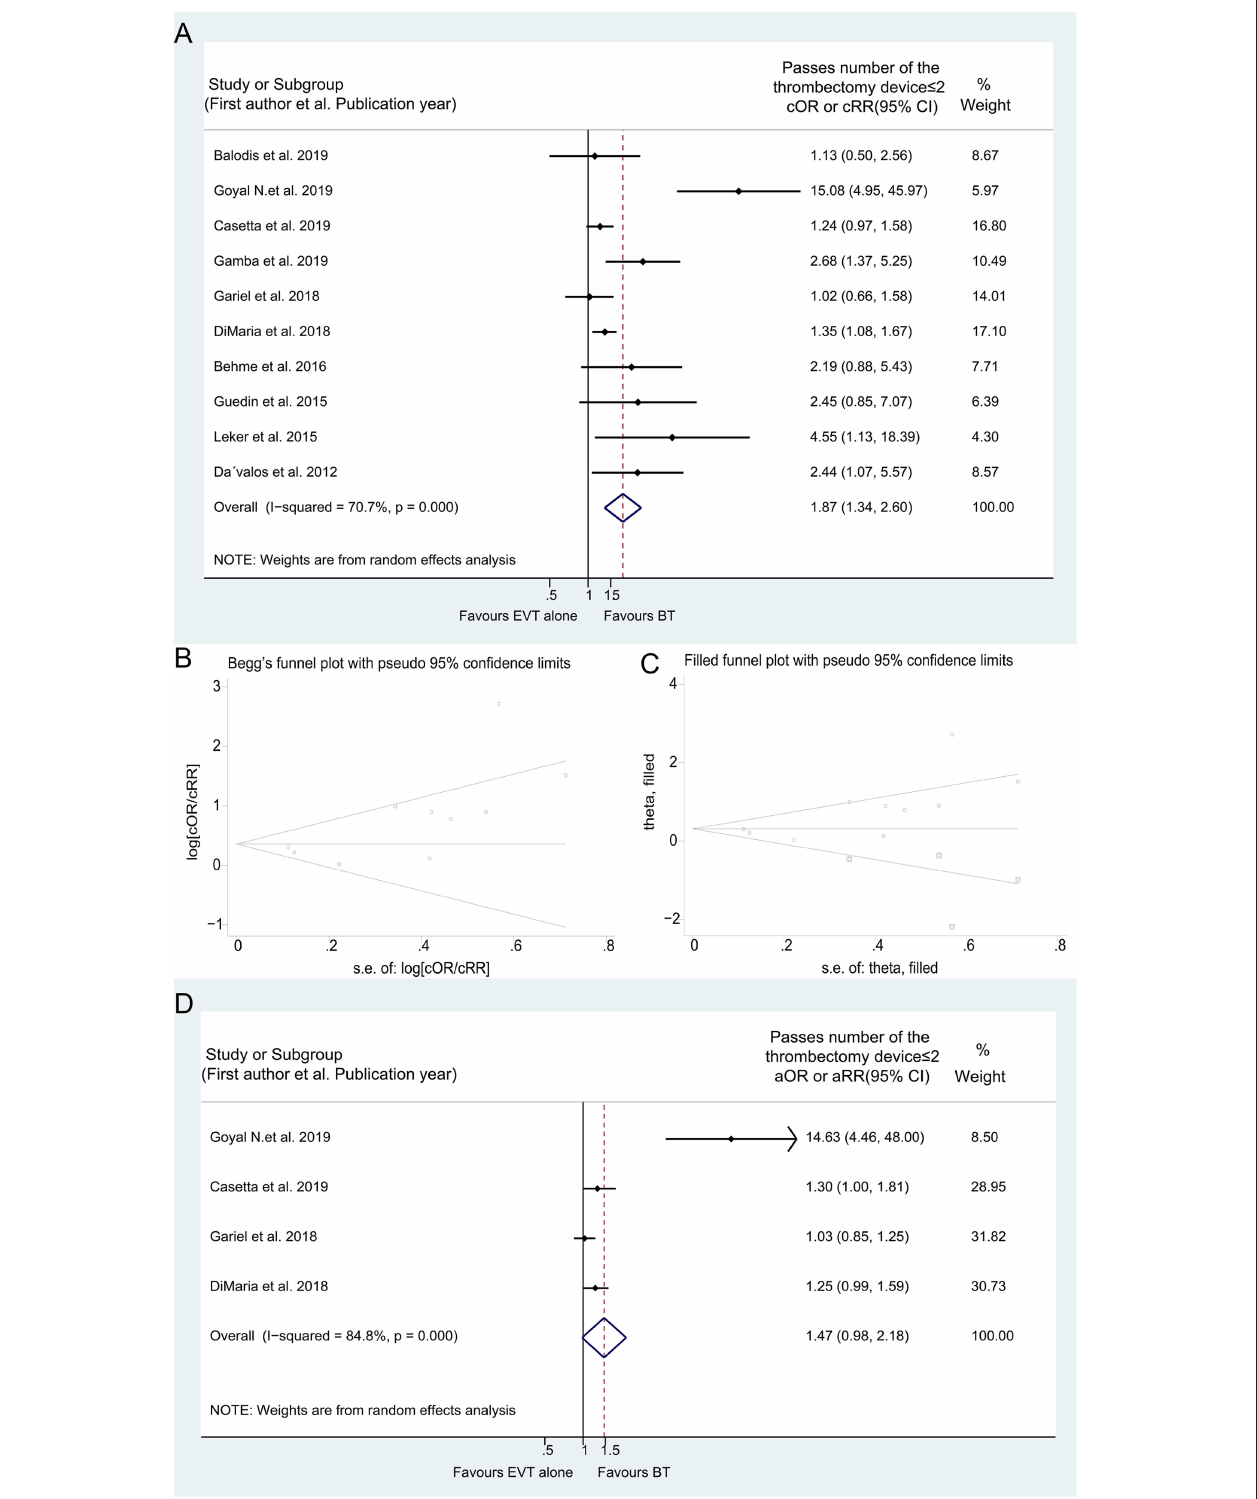
FIGURE 7 | Forest plots of studies assessing number of passes of the thrombectomy device ≤ 2 in unadjusted analysis (A) with related Begg’s funnel plots (B) and “Trim and fill” analysis (C) , and in adjusted analysis (D) .